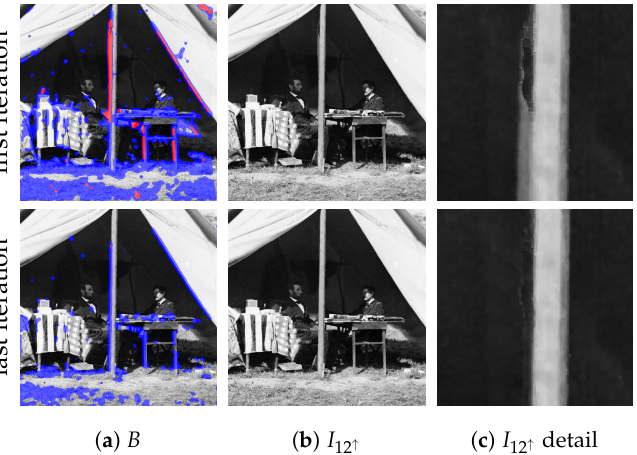
Figure 6. Refinement step (see Section 2.4). First (top row) and last (bottom row) iterations of the detection and adjustment sub-steps. ( a ) detection mask B at the beginning of the iteration, ( b ) updated I c ) details of ( b ). Pixels to be adjusted using L (cid:48) ( L ) are underlined 12 ↑ at the end of the iteration and ( in the images by saturating the red (blue) channel. By inspecting the details, it can be seen that the ghosting effect is removed. Best viewed in color. The reader is invited to zoom in on the electronic version of the manuscript in order to better appreciate the visual